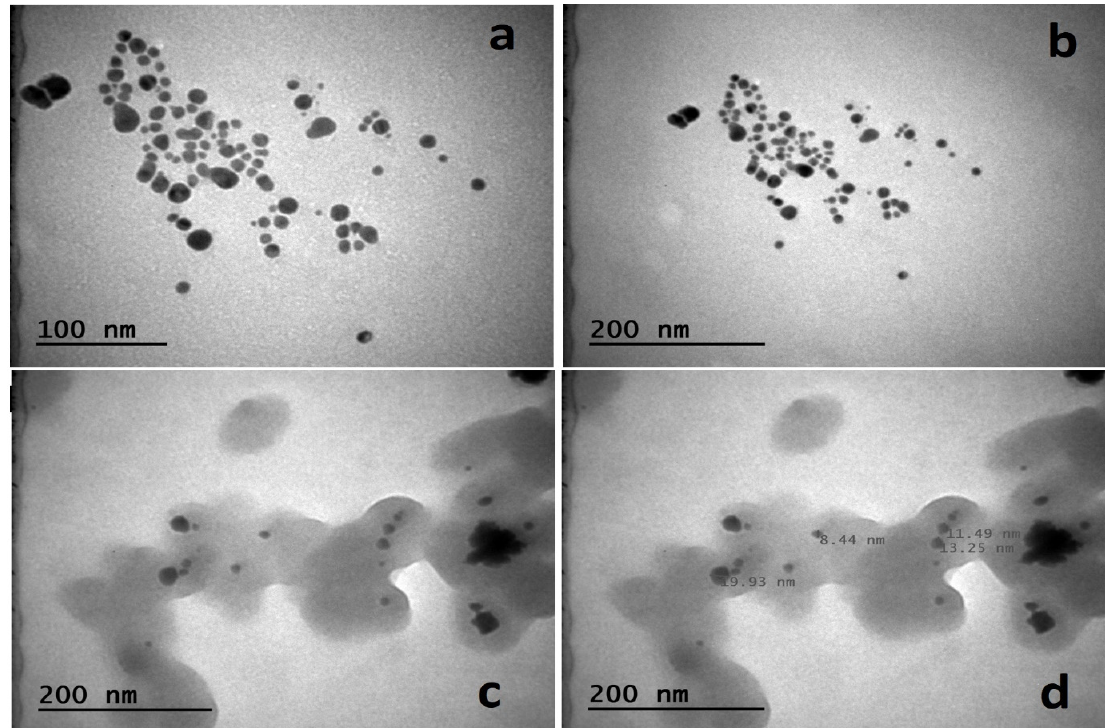
Figure 3. Unsized ( a – c ) and sized ( d ) TEM images of A. cepa -AgNPs.